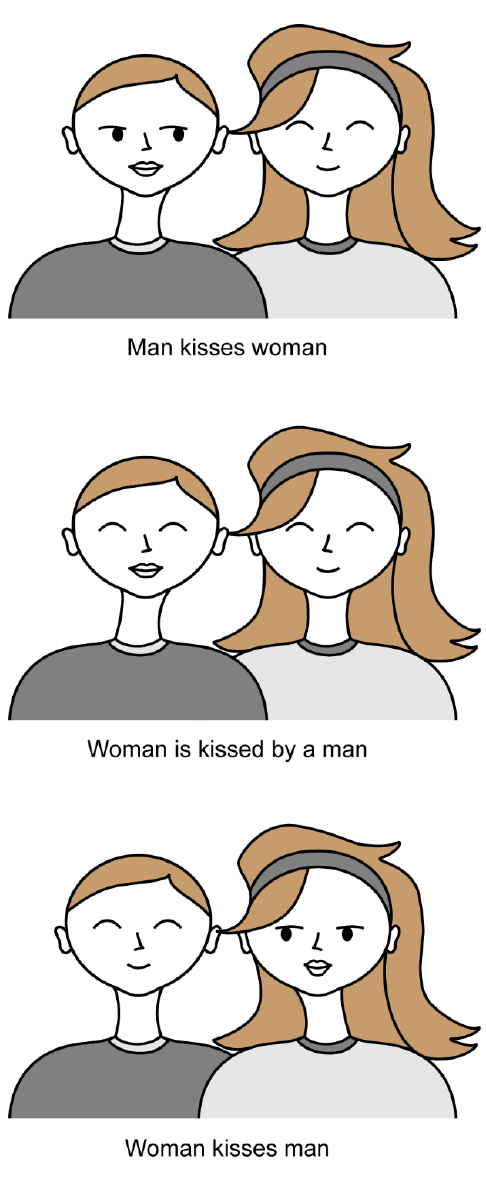
Figure 8. Illustrated example of an iconic syntactic structure that is created and used by MAG- 946 NUS.